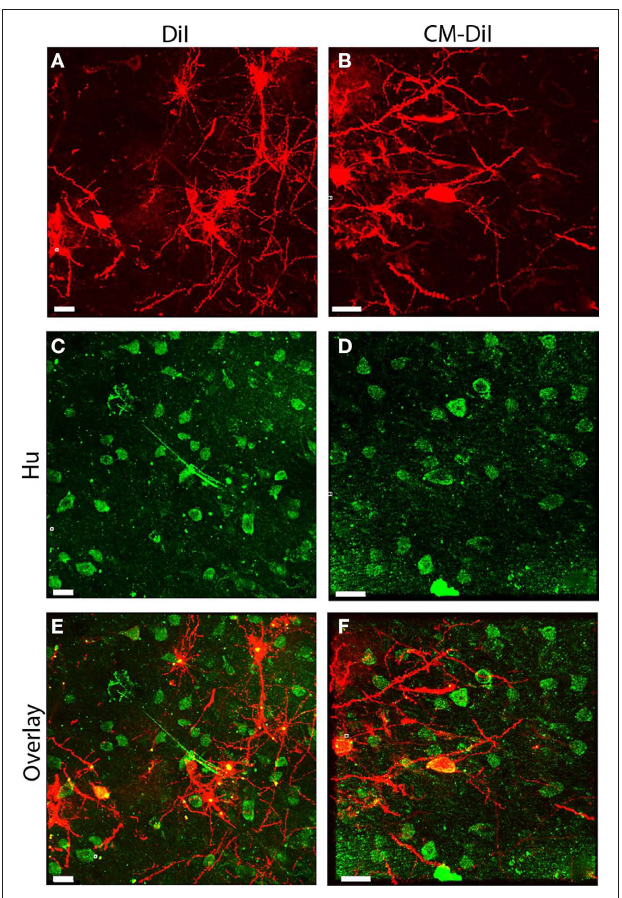
Figure 5 | immunofluorescent labeling can be combined with Dii and CM- Dii labeling. (A) Permeabilized DiI treated tissue. (C) Permeabilized Hu stained tissue from the same field shown in (A) . (e) Overlay of (A,C) demonstrating co-localization of DiI and immunofluorescent Hu signal (yellow). (B) Permeabilized CM-DiI treated tissue. (D) Permeabilized Hu stained tissue from the same field shown in (B) . (F) Overlay of (B,D) demonstrating co-localization of CM-DiI and immunofluorescent Hu signal (yellow). Scale bar is 20 μm.